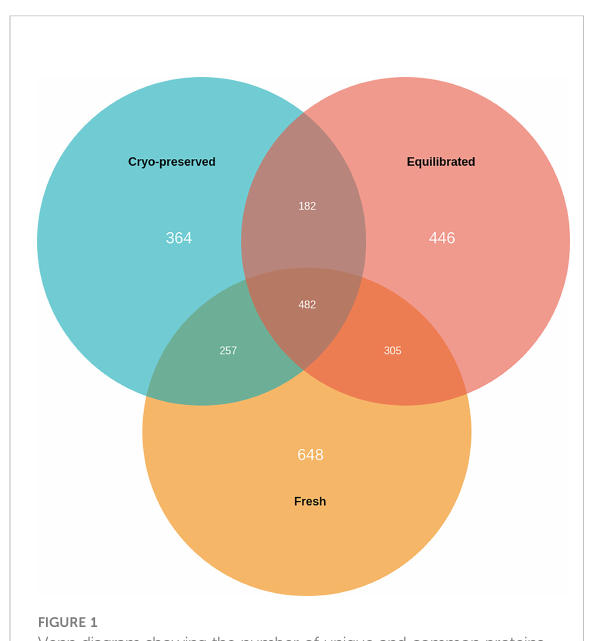
FIGURE 1 Venn diagram showing the number of unique and common proteins present in fresh, equilibrated, and cryopreserved semen samples.